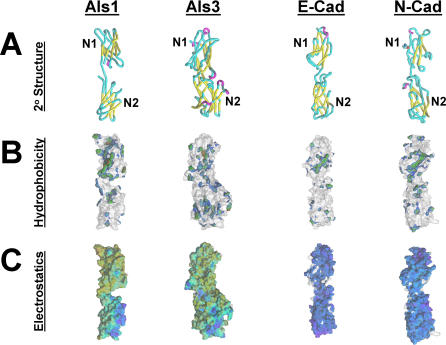
Comparison of the First Two N-Terminal Domains of Als1, Als3, E-Cadherin, and N-CadherinThe most distal (N1) and adjacent (N2) N-terminal domains of Als1, Als3, E-cadherin, and N-cadherin are shown. The predicted structures of the N-terminal regions of Als1 and Als3 were extracted from their larger models, and structures for E-cadherin and N-cadherin were obtained from the Protein Data Bank [62].(A) Comparative secondary structures. Yellow color indicates β-sheet propensity; red, α-helical propensity; aqua, extended or turn structures. Note that the Als1 model encompasses 187 amino acids (residues 3–190) in an equivalent 3-D space as that of Als3, which includes 279 amino acids (residues 20–299). Such a comparison illustrates the overall similarities in conformation among these polypeptide domains, with a more compact configuration of Als3.(B) Comparative hydrophobic surfaces. Surface hydrophobicity is illustrated in color upon the solvent-accessible surface areas of respective molecules. For clarity, only the hydrophobic surface is colored; the ghost structures (gray) represent the polar surface. In hydrophobic areas, brown indicates the most hydrophobic regions and blue indicates the least hydrophobic regions.(C) Comparative electrostatic surfaces. Negatively charged electrostatic surface is illustrated in color upon the solvent accessible surface areas of respective molecules. For clarity, only the negatively charged surface is colored; the ghost structures (gray) represent the small area on each molecule bearing a positive charge. In negatively charged areas blue indicates the strongest negative surface potential and yellow indicates the weakest negative charge potential.